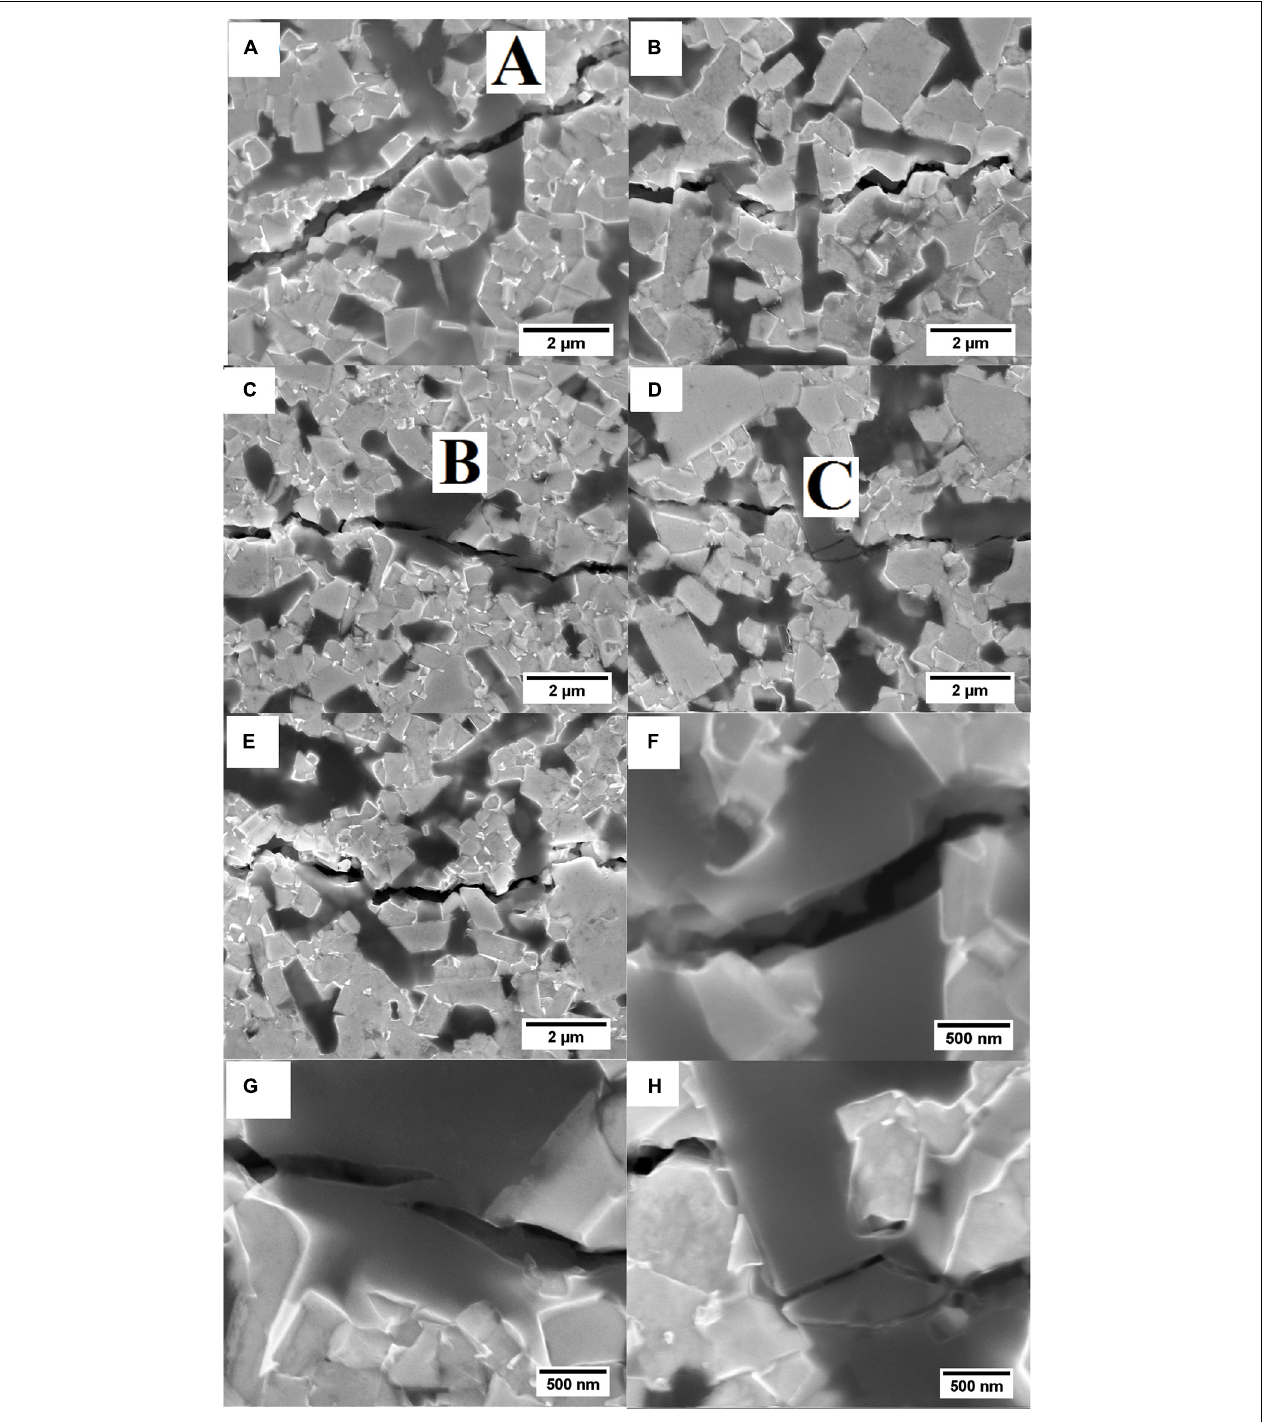
FIGURE 5 | HRSEM images of the indentation crack paths in of (A) 10S, (B) 10S0.01B, (C) 10S0.05B, (D) 10S0.1B, (E) 10S0.15B, (F) A area in (A) , (G) B area in (C) , and (H) C area in (D) .